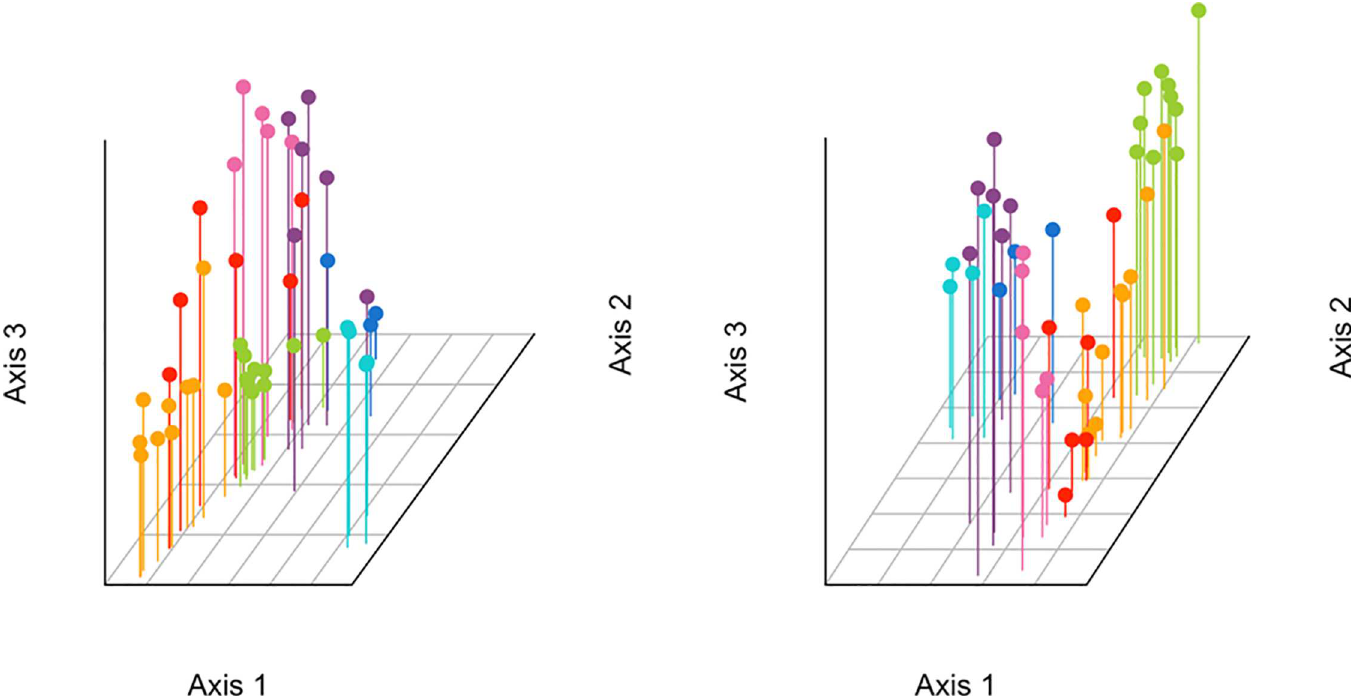
Fig 2. Three-dimensional plots using the first three eigenvalues of sPCA for the SNP (left) and microsatellite (right) datasets for all sub-regions. Values along axes 1, 2 and 3 represent laggedprincipalscores for each genotype relative to the eigenvalue. Colors denote samplingregionsor sub-regions: WBS–light blue, Iceland–darkblue, NOS–purple, SK1 –pink, KB1 –red, BES2 –orange,